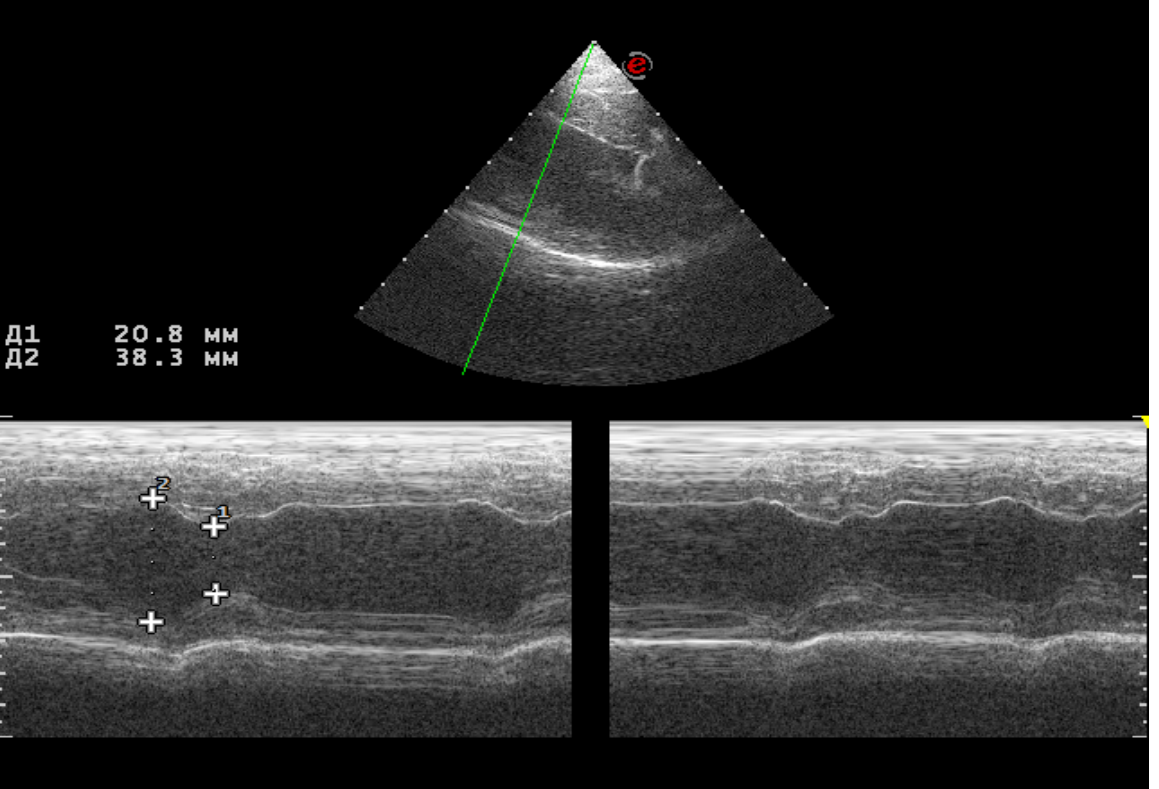
Fig. 3. Ultrasonogram of the dog's heart after 30 days of therapy, M-mode. D1 is the final systolic size, and R2 is the final diastolic size. FS-47 %, PV-79